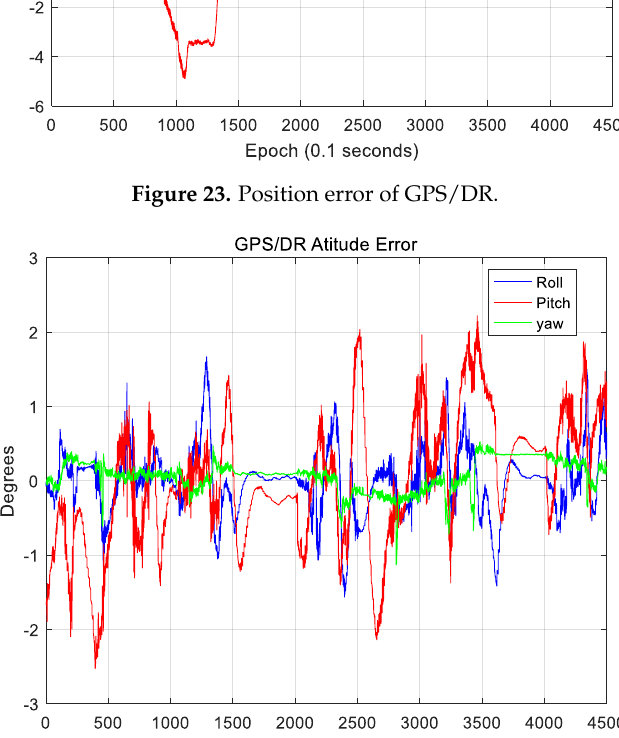
Figure 24. Attitude error of GPS/DR.